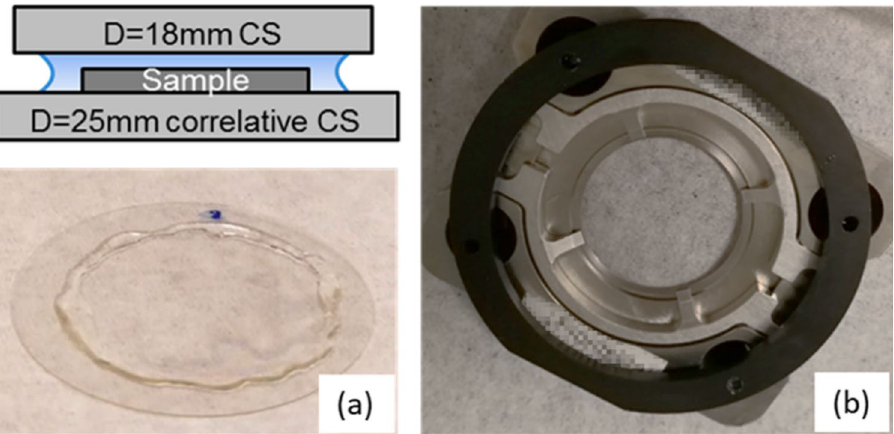
Figure 10. The “sample sandwich” schematic (upper) and photograph (lower) configuration where cultured cells are grown on the lower coverslip, then topped with buffer solution and a second coverslip ( a ). The sandwich is sealed with epoxy.; Sample holder for the iPALM system used to secure the sample sandwich and transfer it into the iPALM imaging path ( b